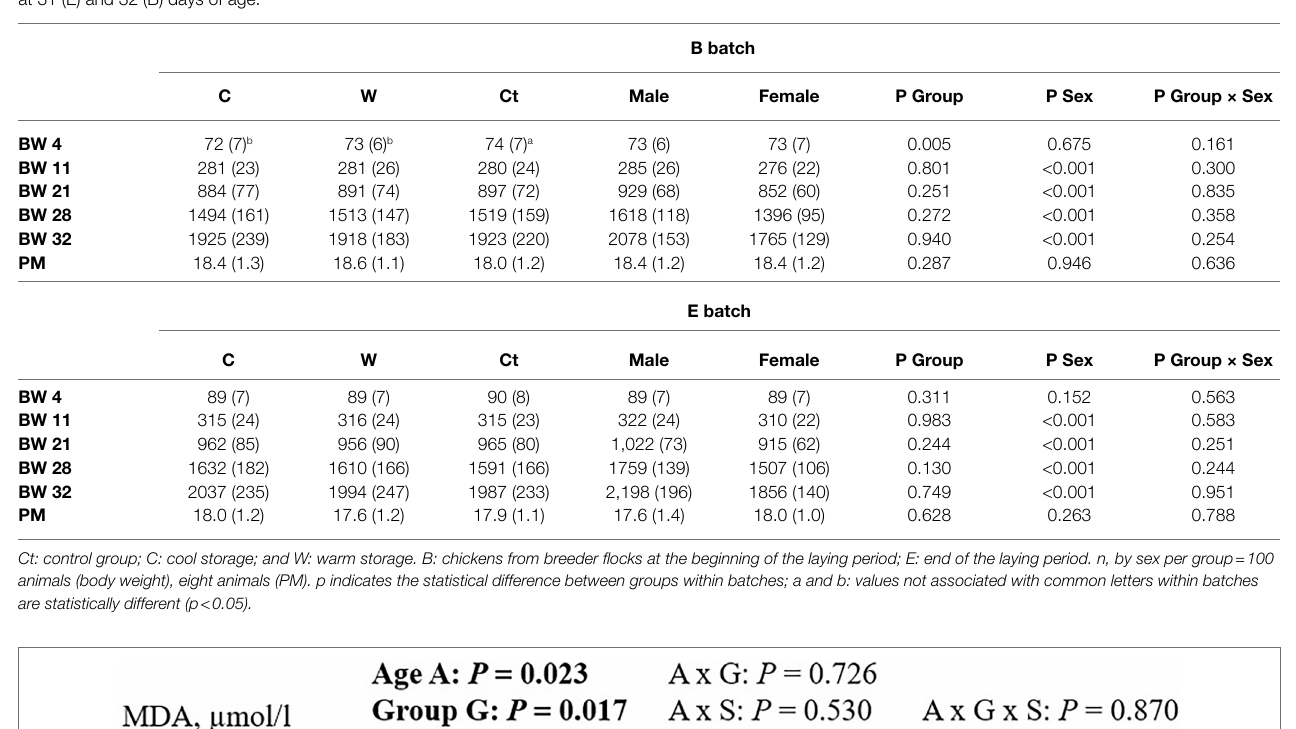
TABLE 4 | Mean (SD) of body weight (BW, g) at 4, 11, 21, 28 and 32 days of age and relative breast muscle weight (pectoralis major PM, % in relation to body weight) at 31 (E) and 32 (B) days of age.